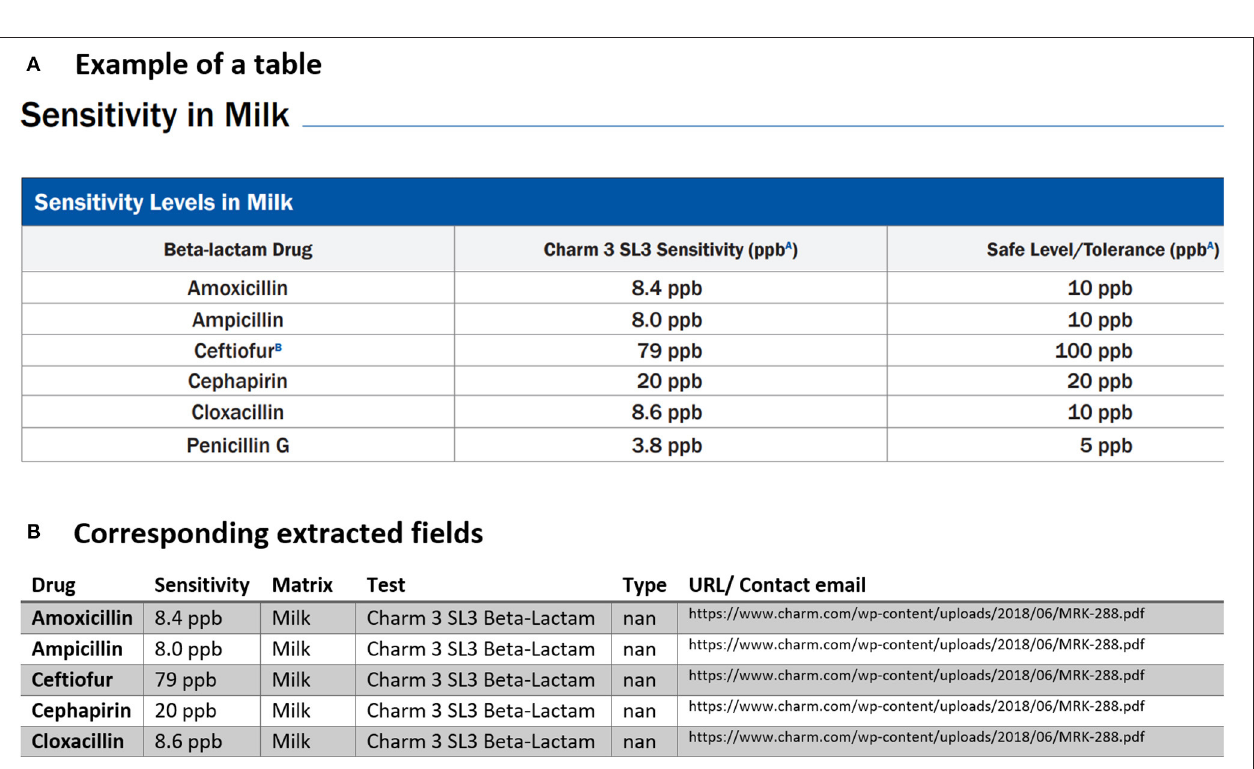
Comparing the Extracted Tables With the Original Excel